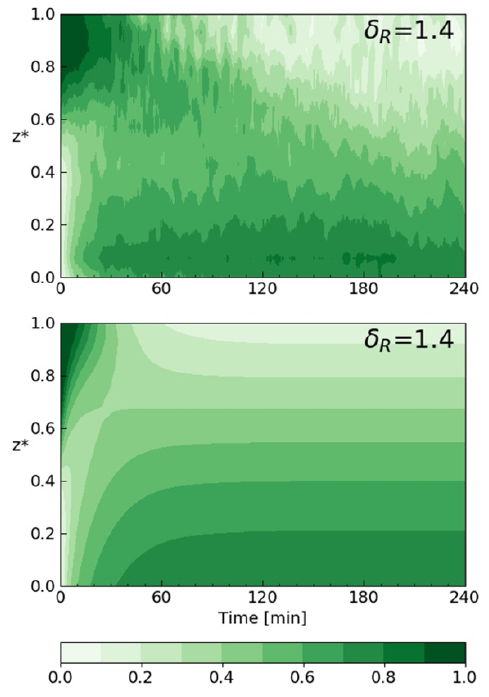
Fig. 6. Experimental measurement (on top) and a numerical simulation (on bottom) of the heavy particle concentration distribution for 𝛿 3 = 3.70